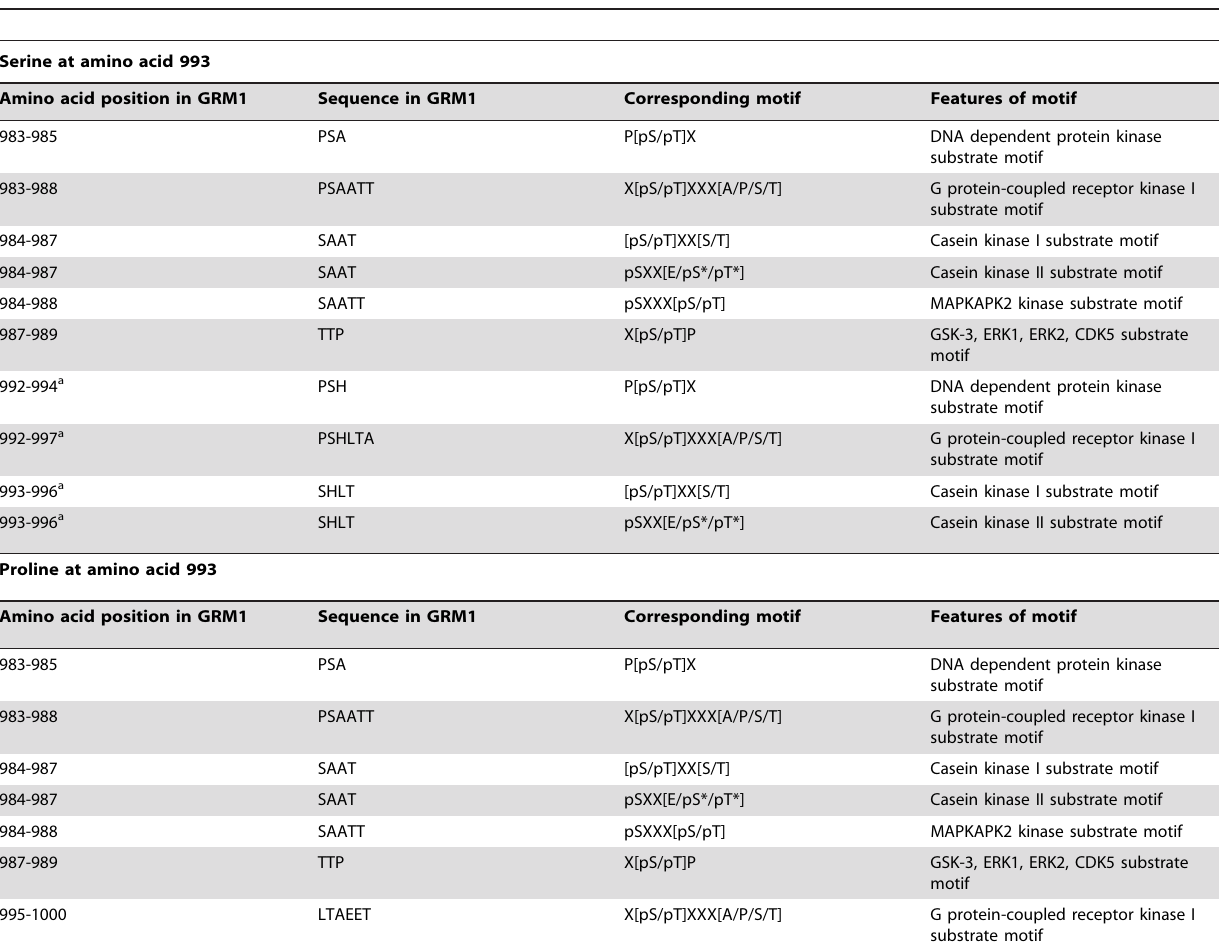
Table 3. In silico analysis of potential phosphorylation of GRM1 amino acid residues as a function of the nonsynonymous SNP